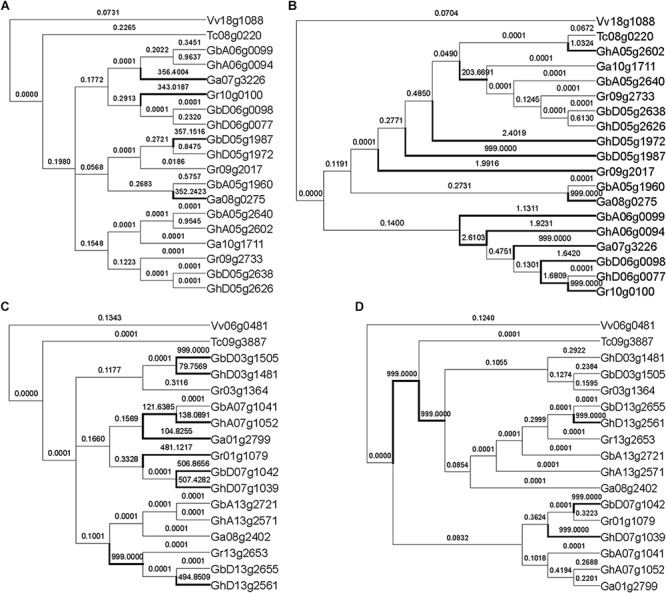
Natural selection inference of MYB genes with expected tree and reconstructed tree. (A) Inference of natural selection of RAD-like genes with the expected topology. (B) Inference of natural selection of RAD-like genes with the reconstructed topology. (C) Inference of natural selection of MYB59 genes with the expected topology. (D) Inference of natural selection of MYB59 genes with the reconstructed topology. The number on the branch is the ω value, and the branch with ω > 1 is marked with a thick line.